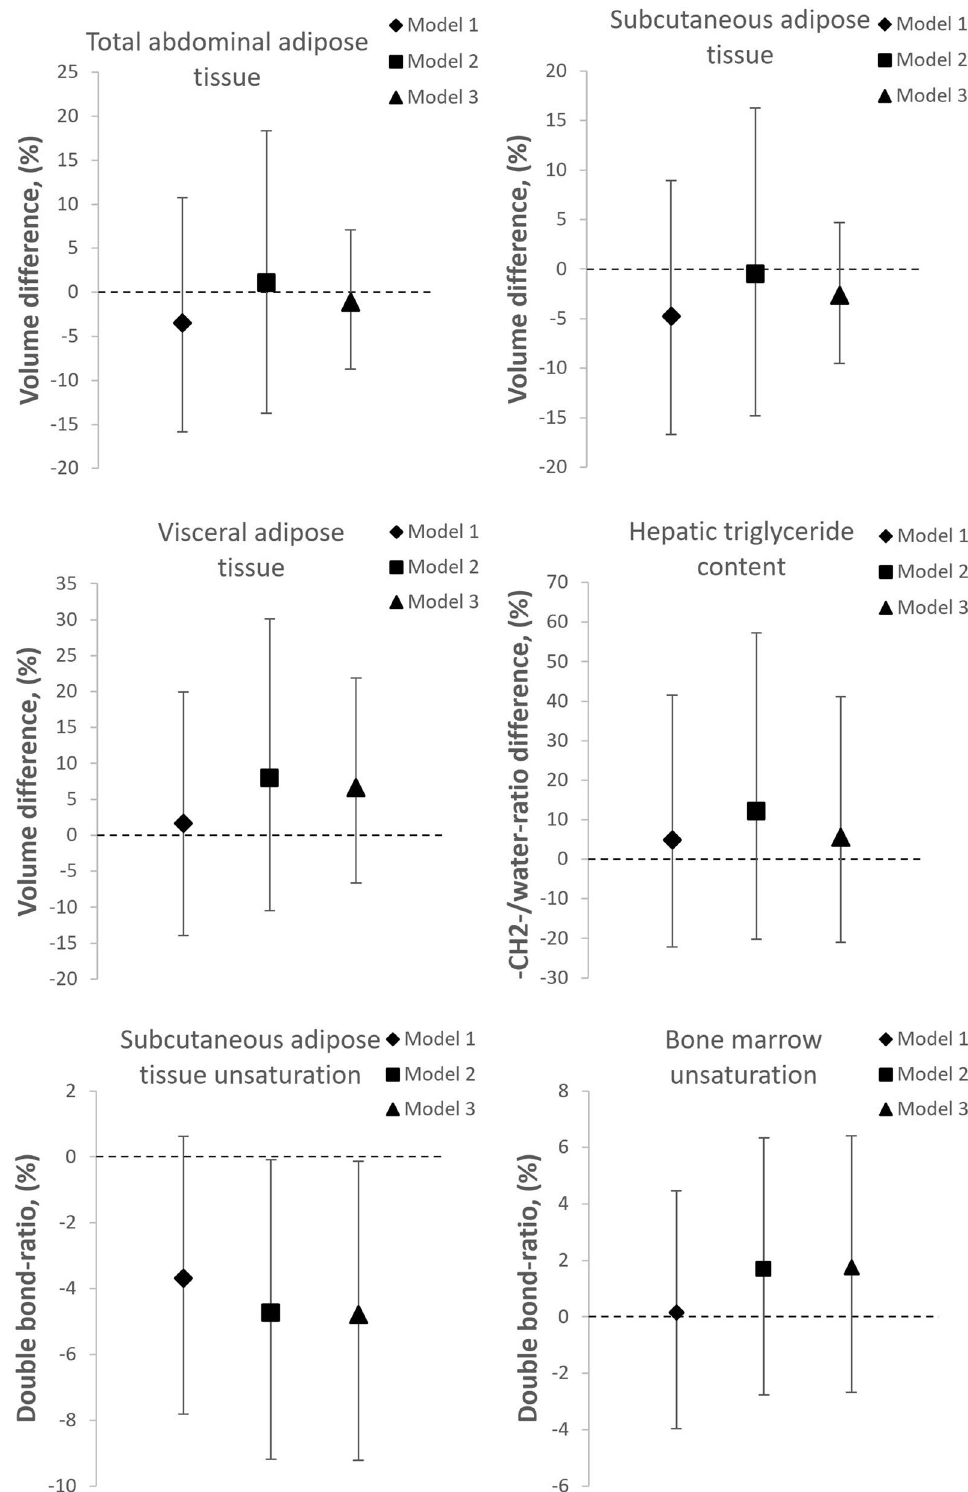
Figure 3. Mean differences (95% CI error bars) of log-transformed volumes of visceral, subcutaneous and total abdominal adipose tissue, hepatic triglyceride content, and subcutaneous adipose tissue and bone marrow unsaturation in adults born at VLBW compared to their term born siblings (zero line). Model 1 adjusted for sex and age at examination. Model 2 further adjusted for primiparity, maternal age, maternal BMI, maternal smoking, gestational hypertension and pre-eclampsia. Model 3 further adjusted for current